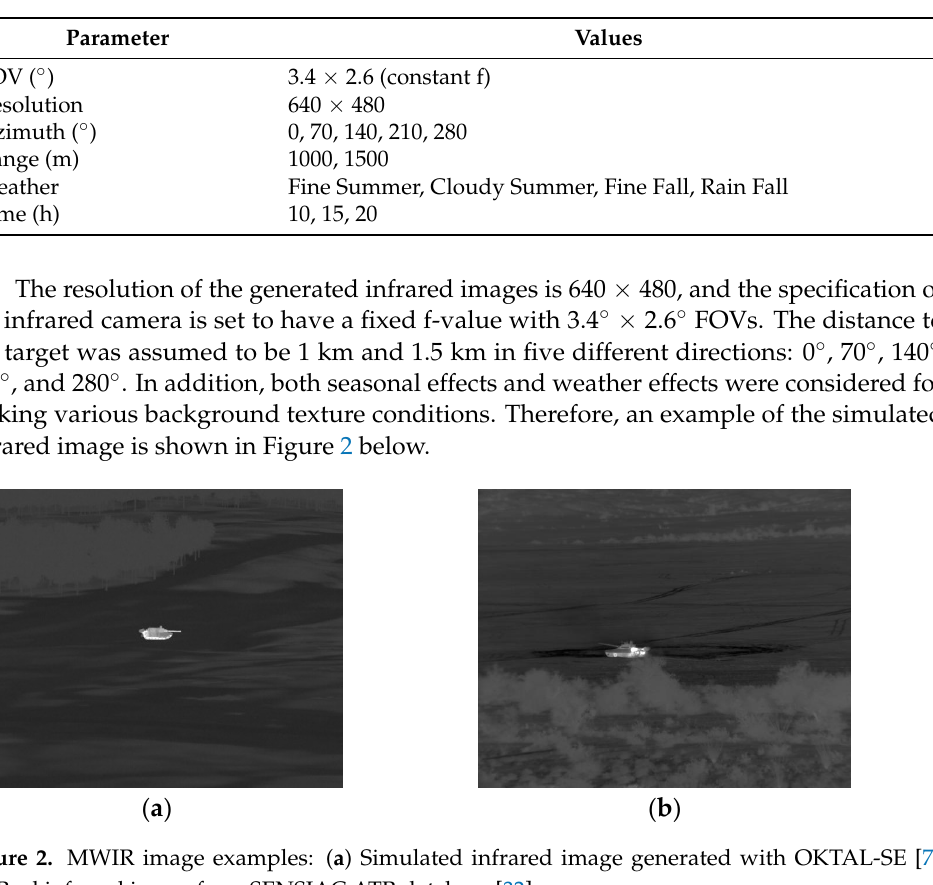
Table 1. Simulated infrared image generation conditions.